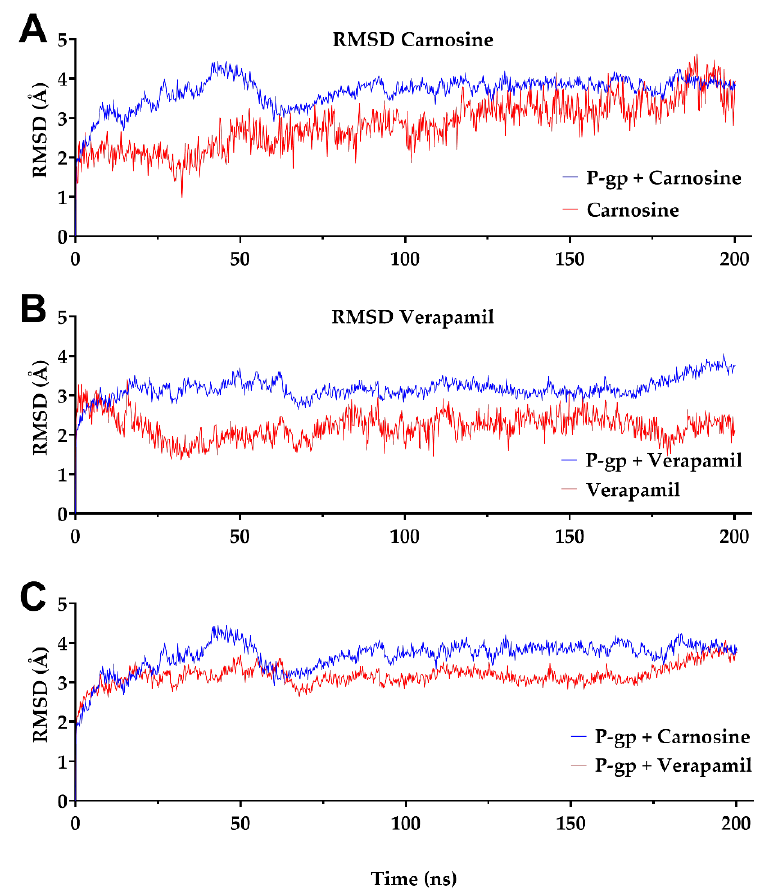
Figure 1. The root mean square deviation (RMSD) of the alpha carbon atoms of P-glycoprotein (P-gp) bound with carnosine or verapamil during 200 ns molecular dynamics simulation. In ( A ) and ( B ), the protein bound with ligands RMSD is shown in blue, while the RMSD values of the ligand [( A ) carnosine; ( B ) verapamil] are shown in red. ( C ) Compares the RMSD values of the alpha carbon atoms of P-gp bound with carnosine (blue) or verapamil (red) during 200 ns simulation. The PDB file 6QEX was selected as a template of P-gp and used for molecular dynamics simulations in the absence or presence of ligands (carnosine or verapamil) throughout 200 ns using the Desmond package of Schrödinger, as described in further detail in Section